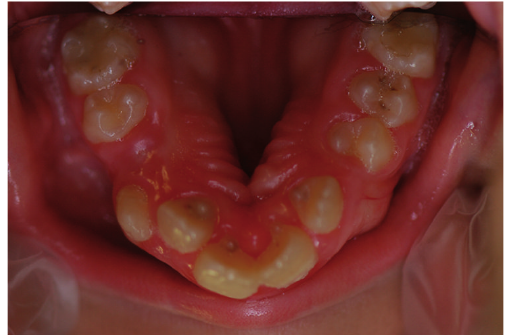
Figure 4: Talon cusps were present on maxillary central and lateral incisors.